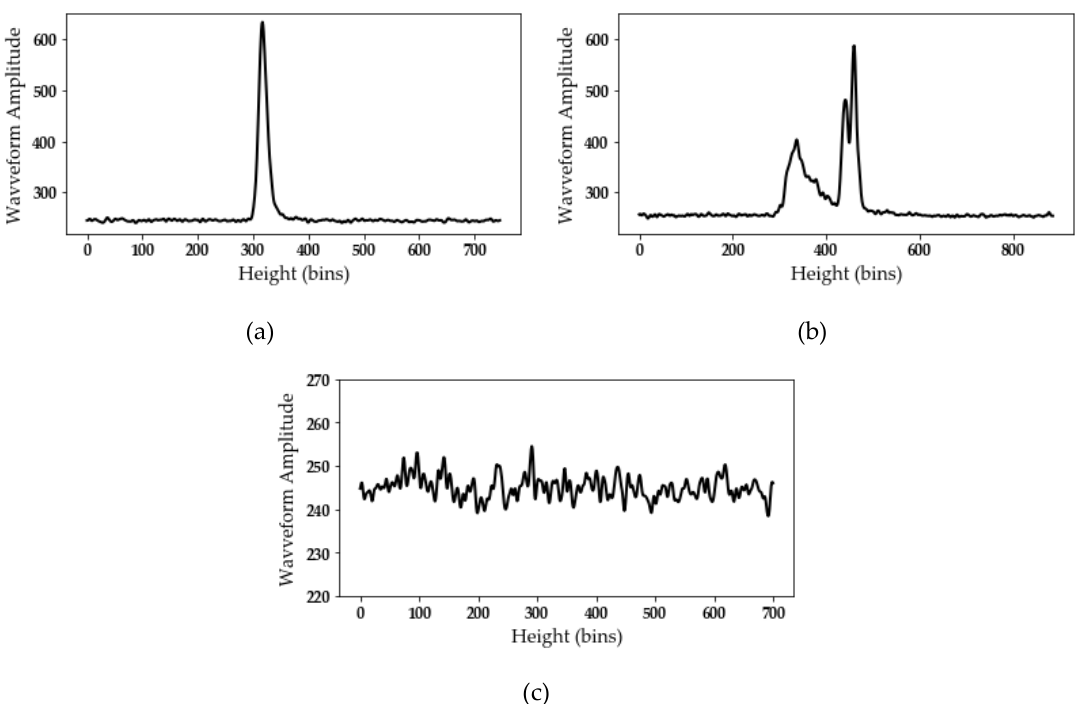
Figure 2. Typical GEDI waveforms over a lake ( a ) and a forest stand ( b ). An unusable waveform due probably due to cloud conditions is shown in ( c ).